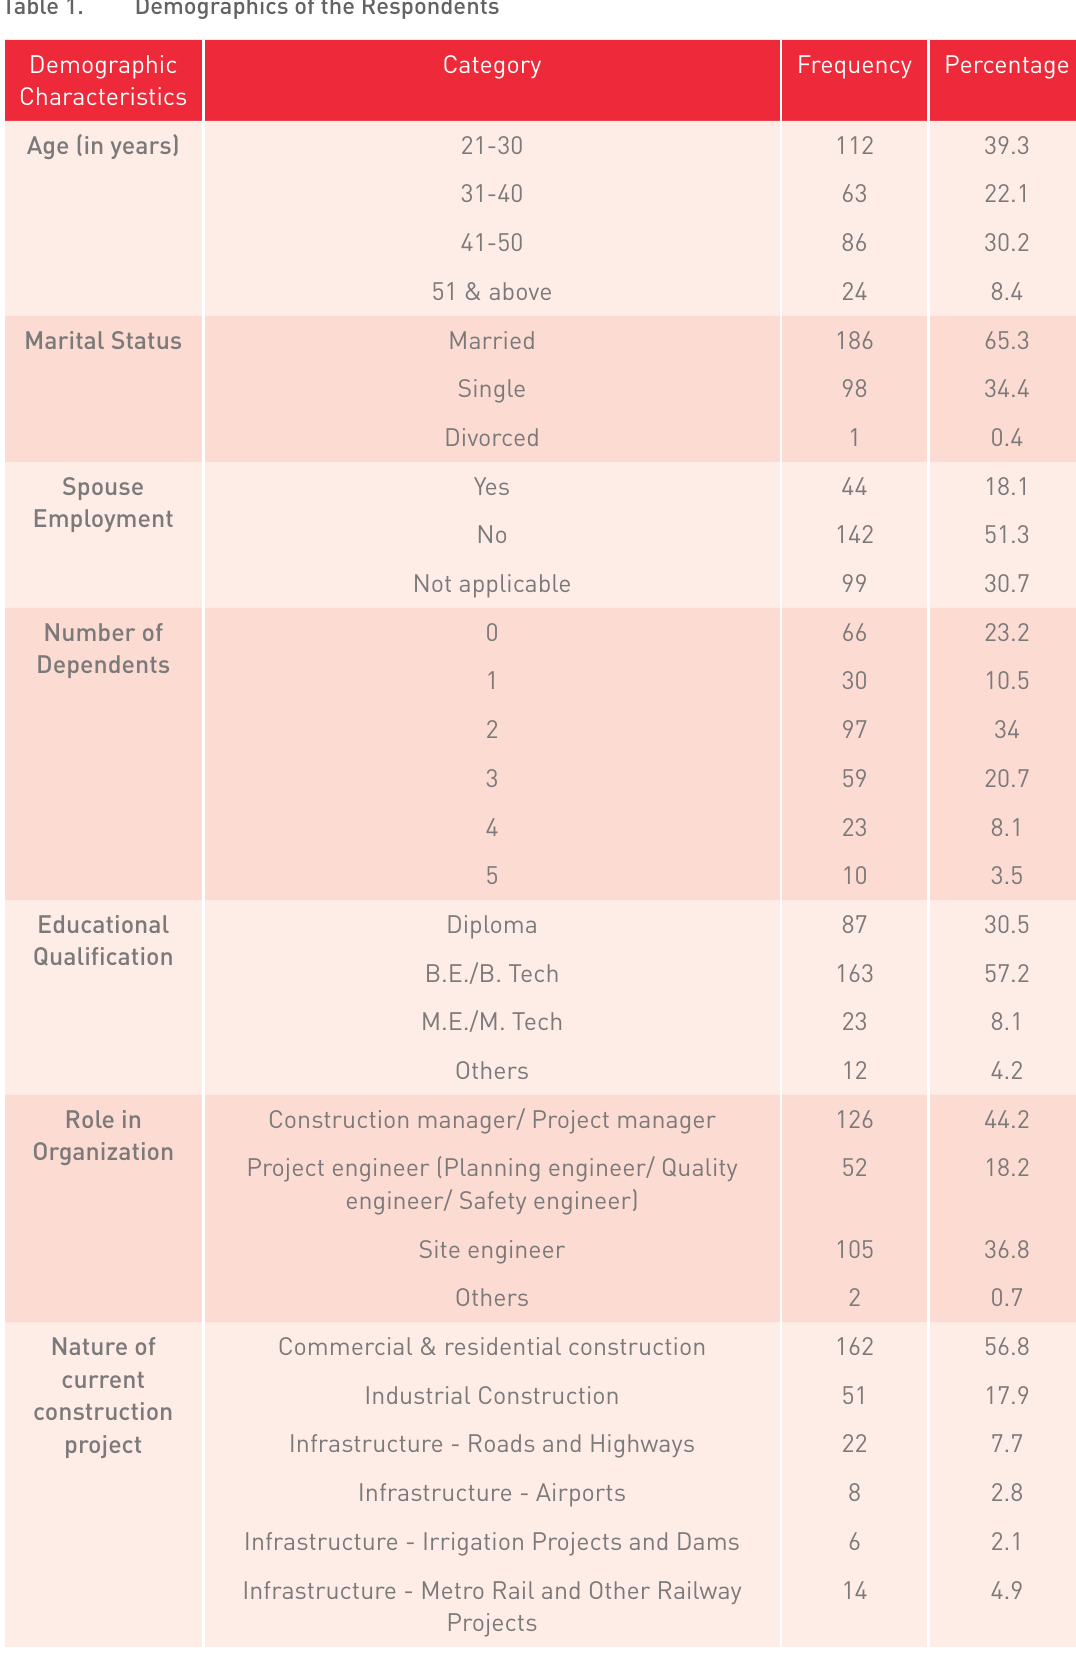
Demographics of the